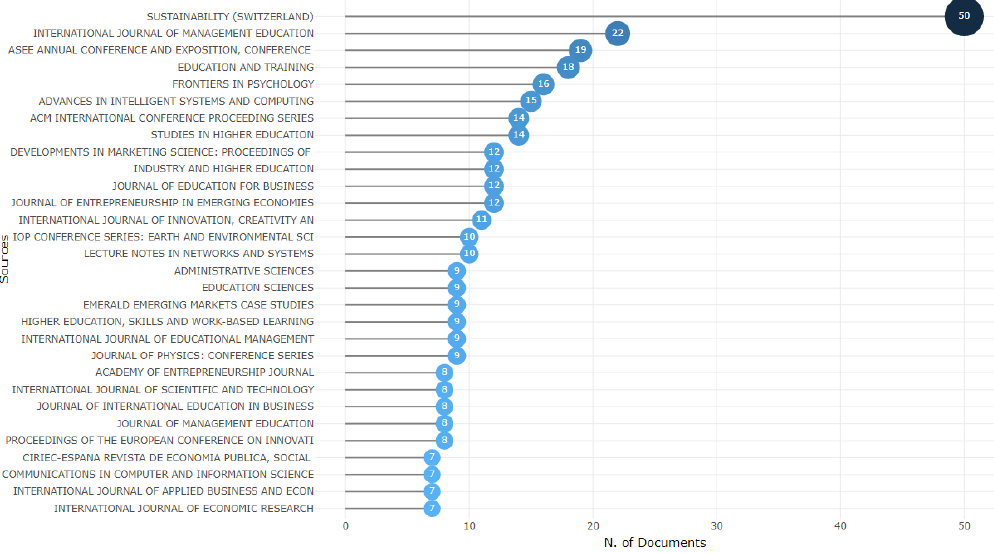
Figure 2. Top 30 Most Significant Journals by the Number of Published Materials in Terms of the Correlation of the Concepts of Education and